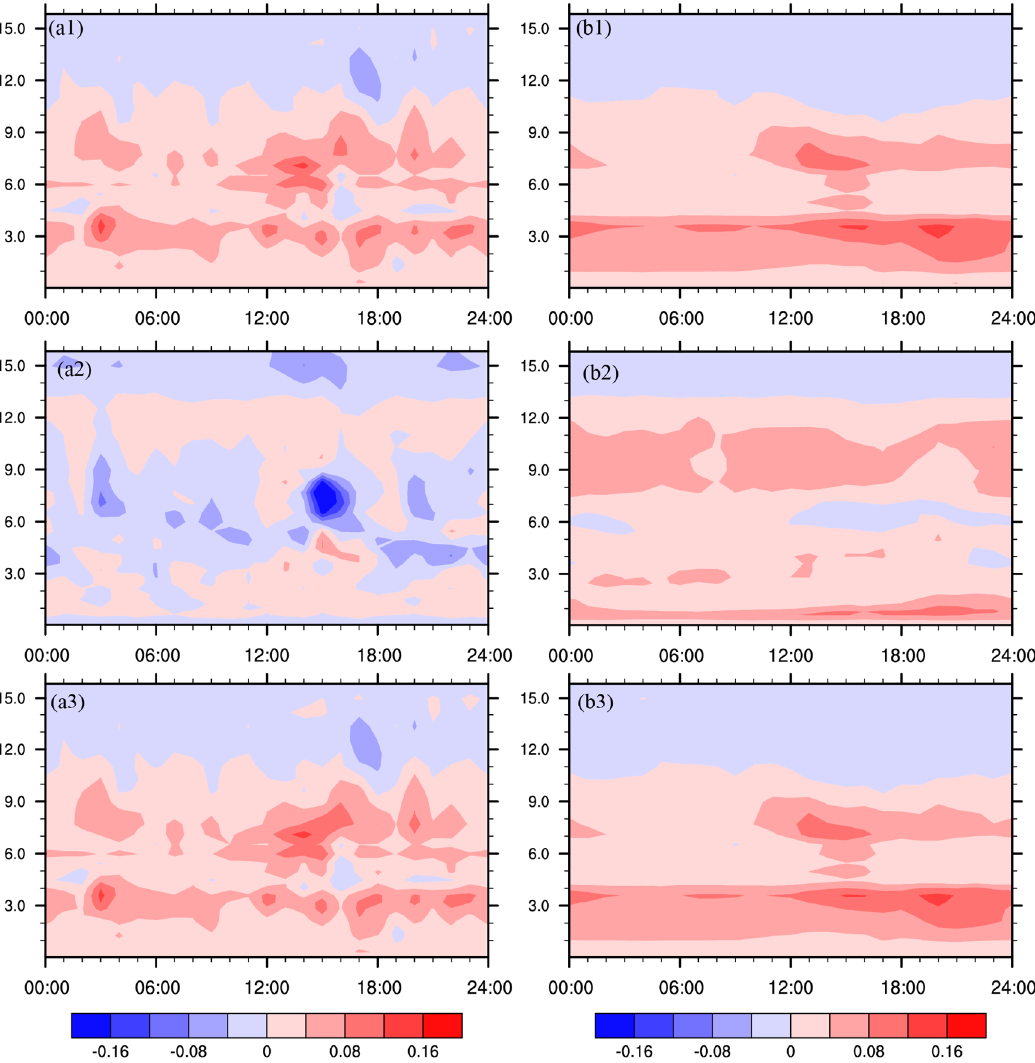
Figure 6. Diurnal composite of ( a1 ) the tendency of the perturbation kinetic energy ( ∂ K (cid:48) ), ∂ t ( a2 ) C u ( K , K (cid:48) ) , and ( a3 ) G T ( K (cid:48) ) + G qv ( K (cid:48) ) + G ql ( P (cid:48) ) in the 2D model runs, and ( b1 ) the tendency of the perturbation kinetic energy ( ∂ K (cid:48) ), ( b2 ) C u ( K , K (cid:48) ) + C v ( K , K (cid:48) ) , and ( b3 ) G T ( K (cid:48) ) + G qv ( K (cid:48) ) + G ql ( P (cid:48) ) ∂ t in the 3D model runs. The units are 10 − 1 J m − 2 s − 1 for barotropic conversion and J m − 2 s − 1 for the other